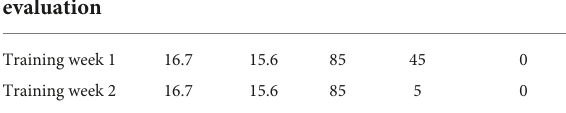
TABLE 6 Values in the POMS factors of Subjetc 3 after training. Time of